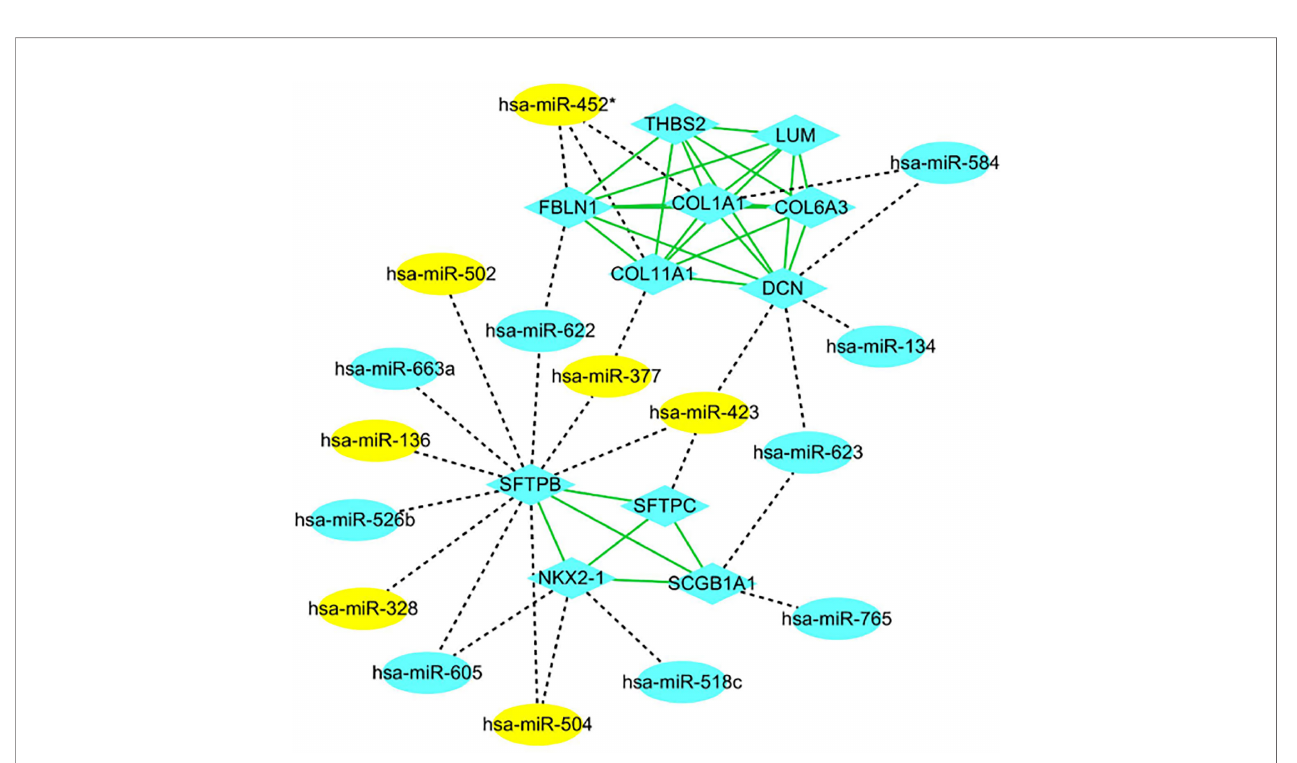
FIGURE 4 | PPI network of hub genes and key miRNAs. mRNAs and miRNAs are indicated as ellipsoid and diamond, respectively. The gray dotted line represents the interaction of the miRNA-mRNAs. The green line represents the interaction of the proteins. The yellow indicates high expression, and blue indicates low expression. * indicates